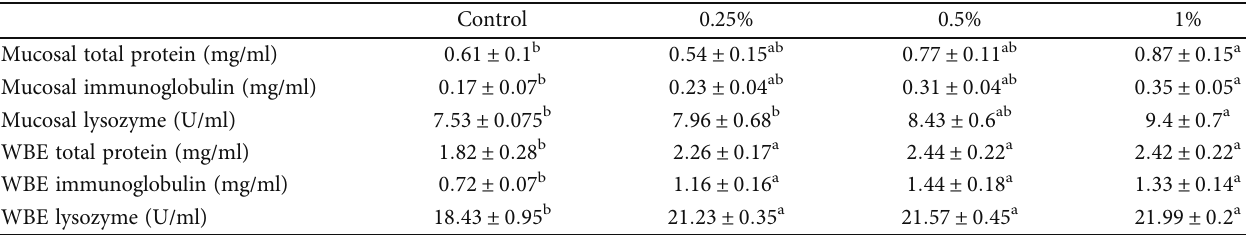
Table 3: The e ff ects of zebra fi sh fed diets containing di ff erent levels of U. intestinalis on immune parameters in skin mucus and